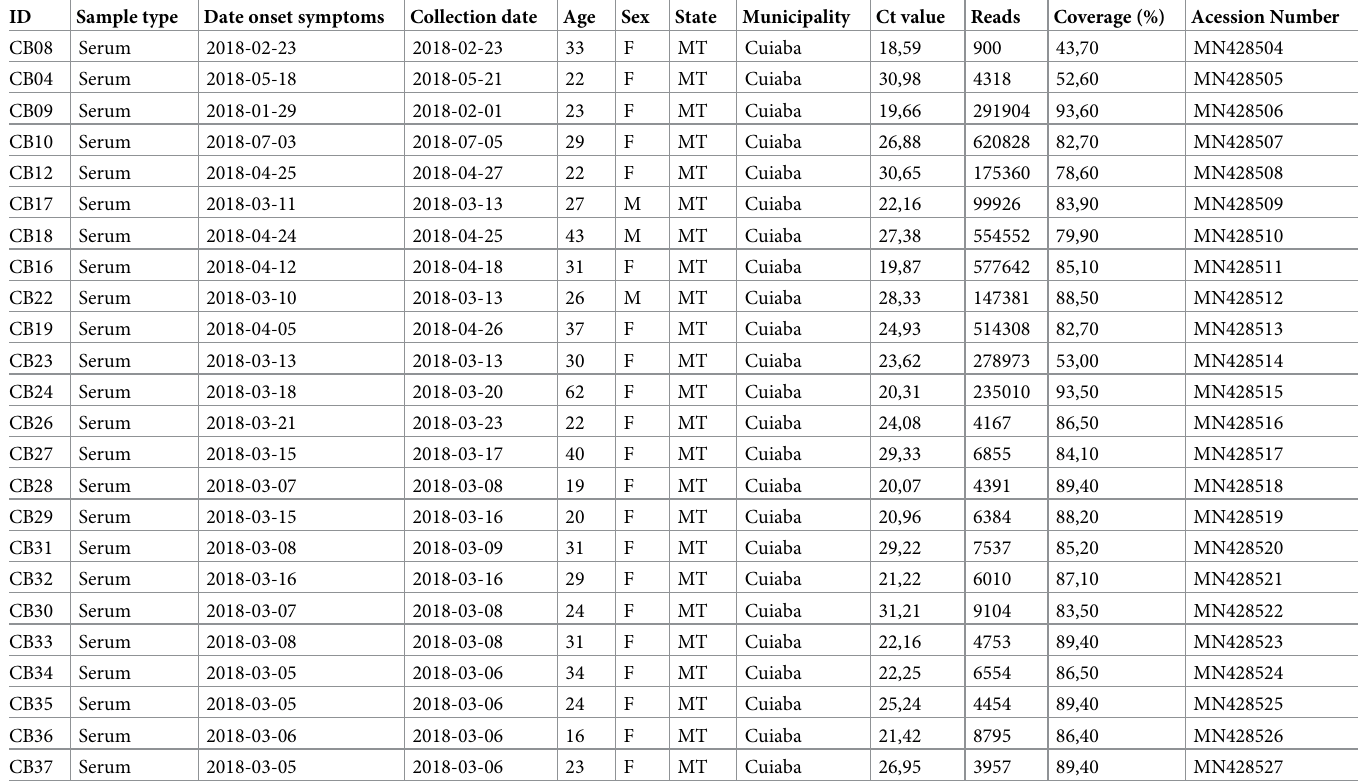
Table 1. Epidemiological data for the sequenced